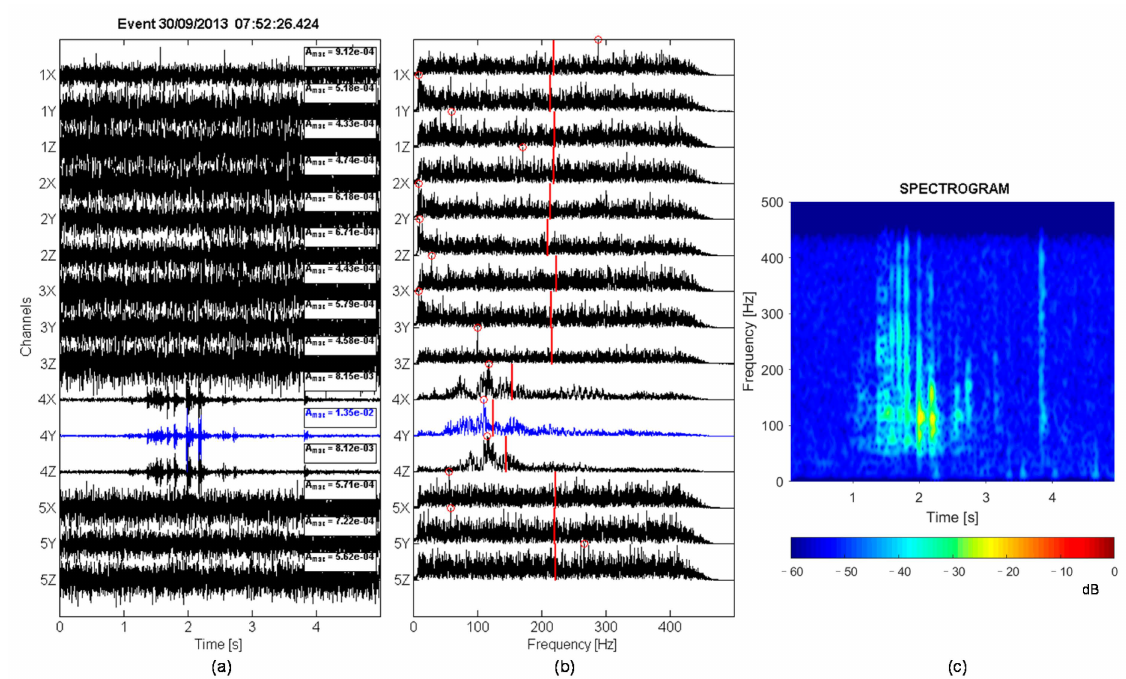
Figure 4. Example of local events. ( a ) Signals recorded by 15 channels. ( b ) Fourier spectra. ( c ) Spectrogram generated by stacking the spectrograms of all